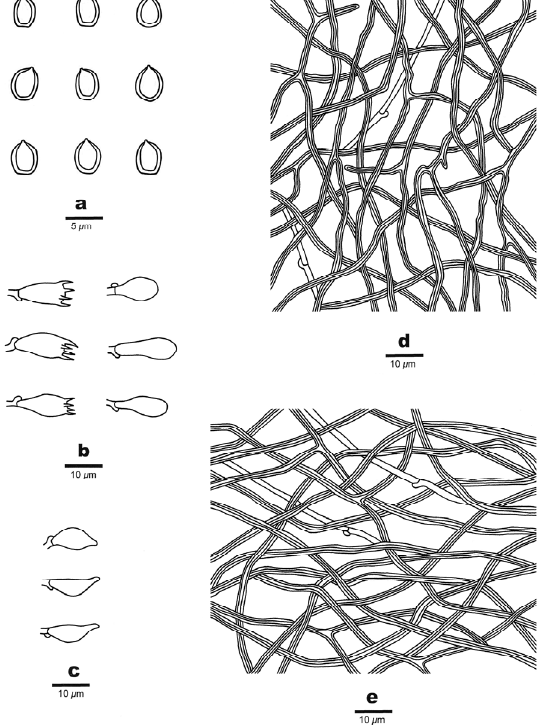
Figure 6. Microscopic structures of Niveoporia subrusseimarginata (Holotype). ( a ). Basidiospores. ( b ). Basidia and basidioles. ( c ). Cystidioles. ( d ). Hyphae from trama. ( e ). Hyphae from context. MycoBank: MB